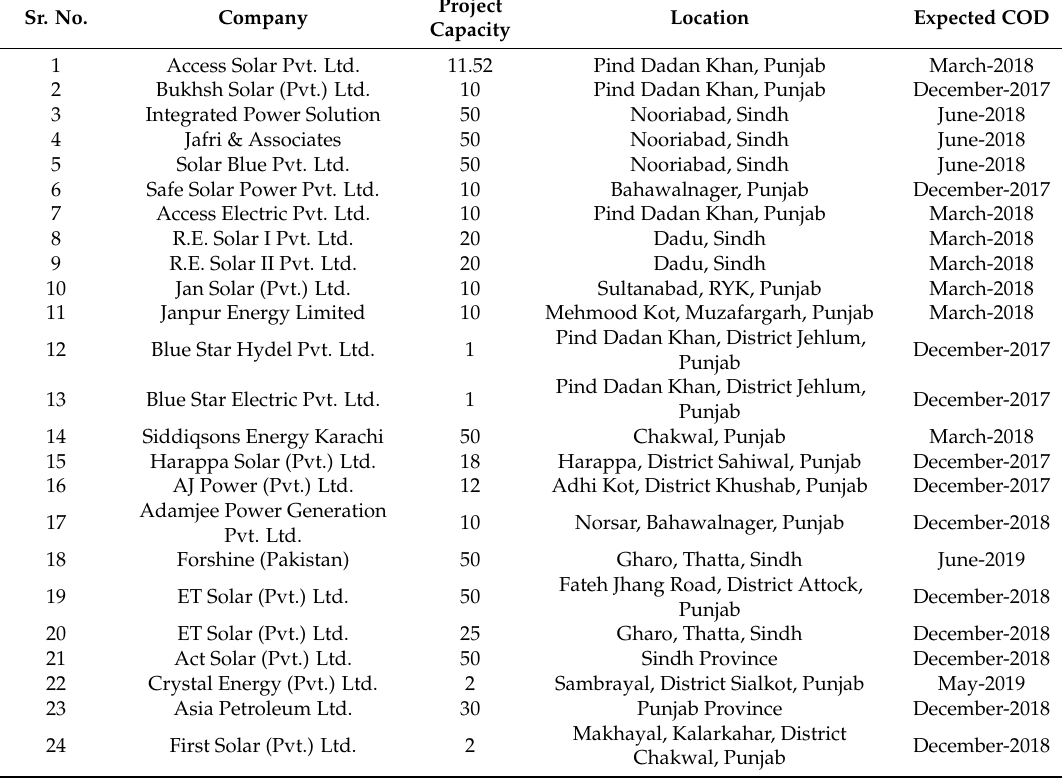
Table 12. Solar PV projects under development with their capacities and estimated COD. Sr.